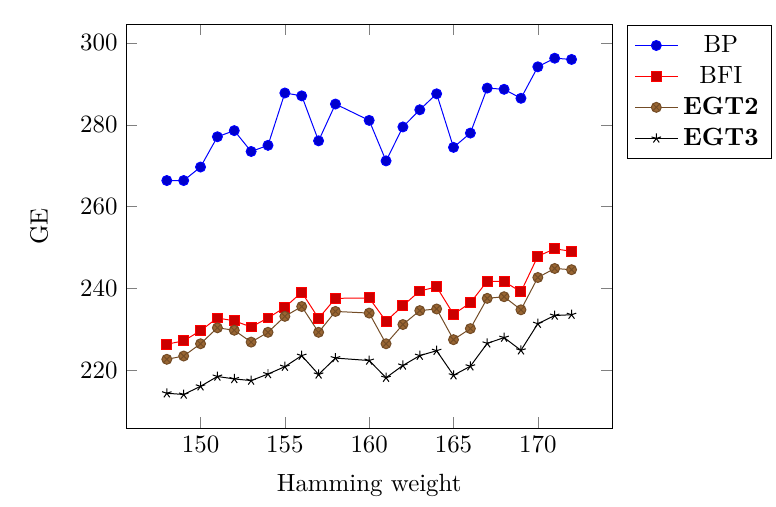
Figure 2: The results of lightweight matrices with the Hamming weight from 148 to 172 for STM 130 nm library, where the Hamming weight counts the number of 1’s contained in the